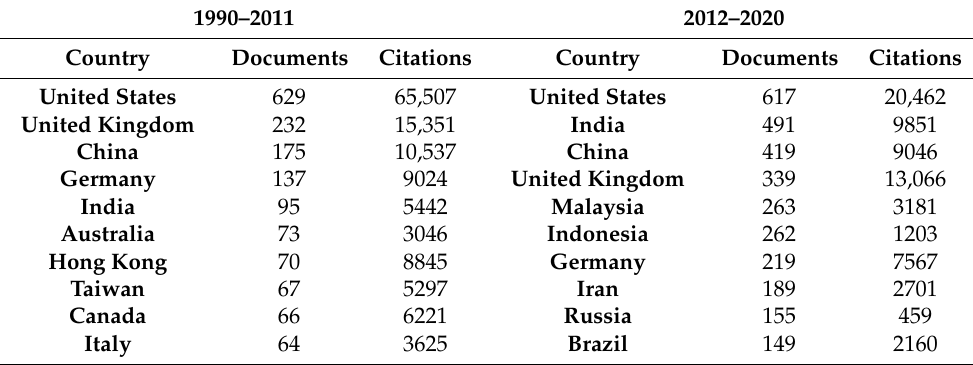
Figure 5. Keyword co-occurrence network regarding SCM between 2012 and 2020. Table 2. The 10 most publishing countries in the two